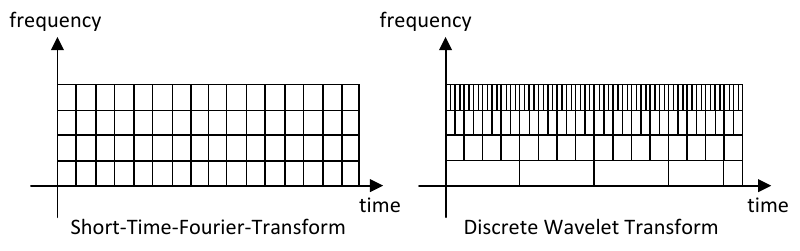
Figure 1. Time-frequency resolution of different transform-based